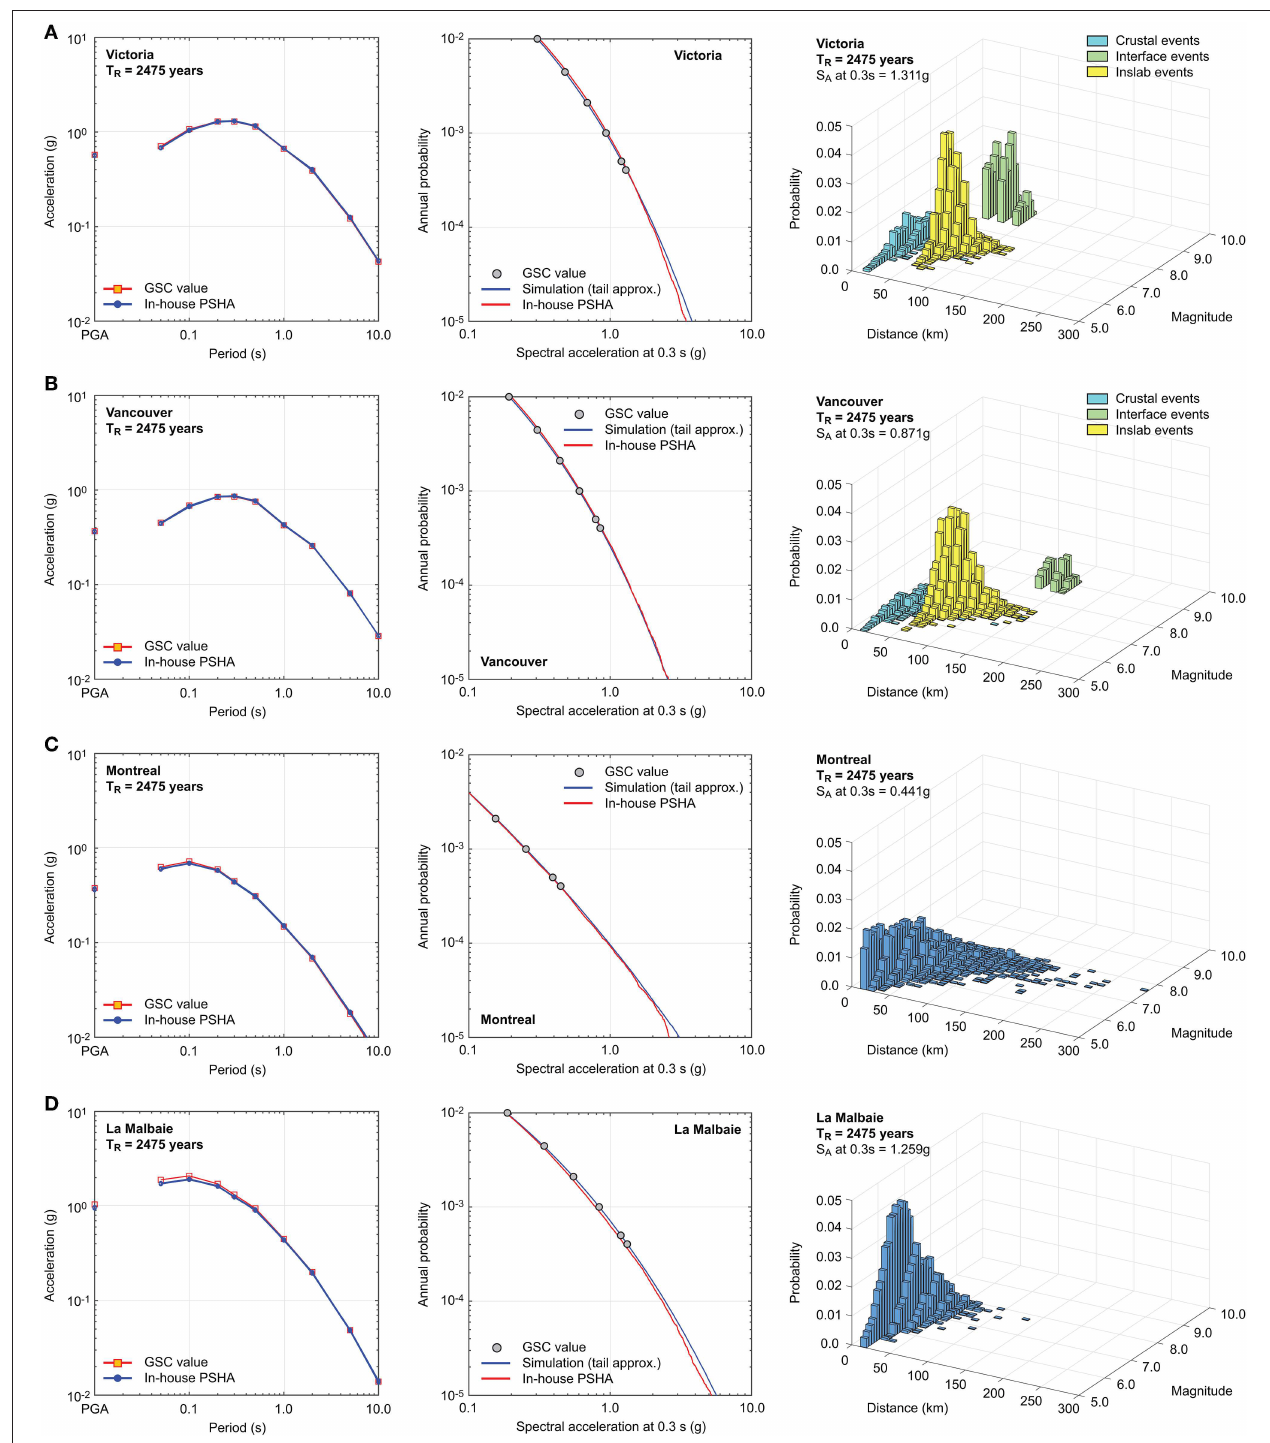
FIGURE 3 | Uniform hazard spectrum at the 2,475-year return period, seismic hazard curve for spectral acceleration at 0.3s, and seismic disaggregation plot for spectral acceleration at 0.3s at the 2,475-year return period: (A) Victoria, (B) Vancouver, (C) Montreal, and (D) La Malbaie.